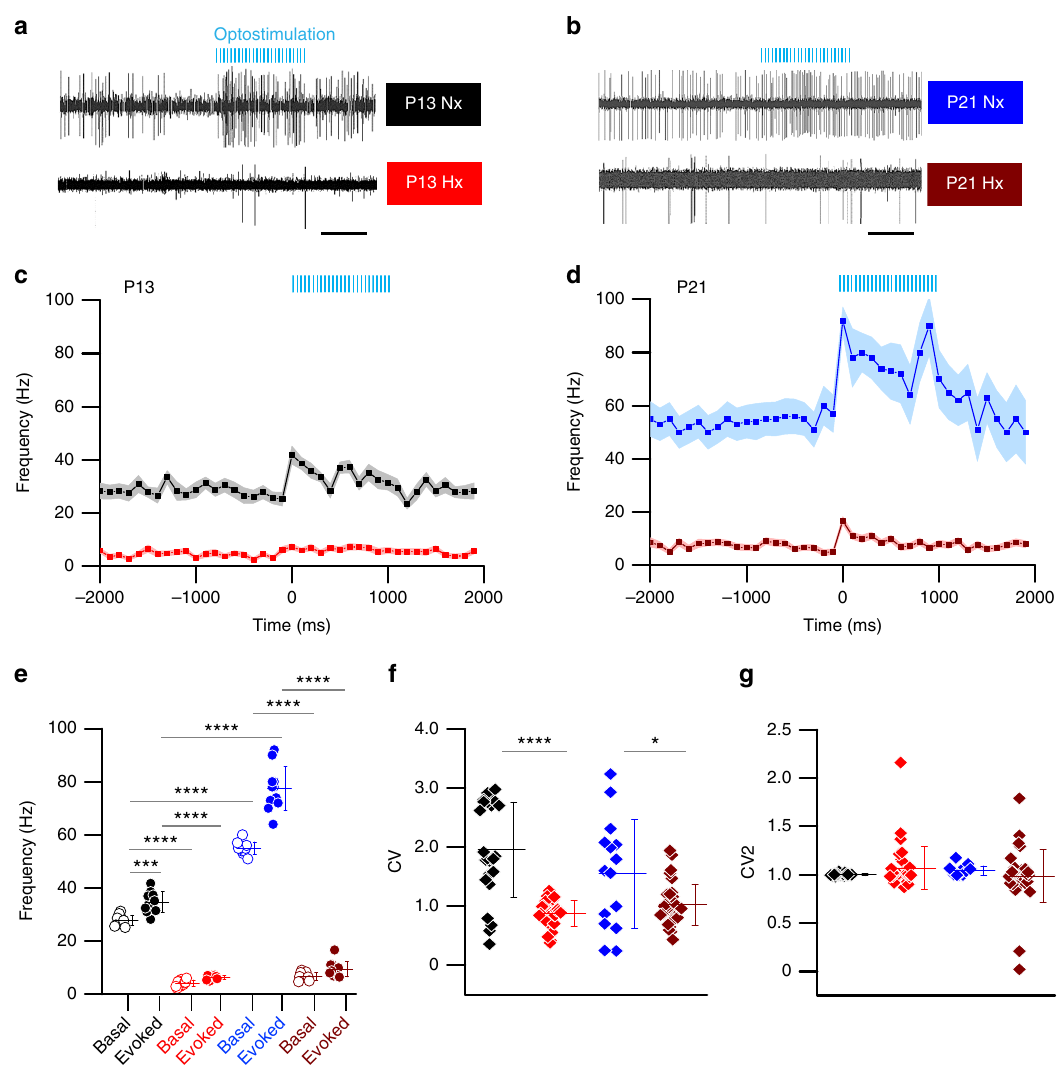
Fig. 6 Altered in vivo Purkinje cell simple spike fi ring rates in Hx and Nx Pcp2-Cre mice at P13 and P21. a Representative multielectrode array (MEA) recordings from Purkinje cells (PCs) in Nx (black) and Hx (red) animals at P13. Blue bars represent optostimulation. b Representative MEA recordings from PCs in Nx (blue) and Hx (wine) animals at P21. c Mean simple spike (SS) fi ring frequency of PCs in Nx P13 (black, n = 25 PCs), and Hx P13 animals (red, n = 37 PCs); shaded area indicates SEM for P13 Nx (light grey), and P13 Hx (light red). d Mean SS frequency of PCs in Nx P21 (blue, n = 15 PCs) and Hx P21 (wine, n = 33 PCs). SEM indicated for P21 Nx (light blue) and P21 Hx (light red). Data obtained from multiple PCs from 8 – 10 animals/group for c – d . e Scatter plot SS frequency comparison of Nx P13 basal (black, open), Nx P13 evoked (black, solid), Hx P13 basal (red, open), Hx P13 evoked (red, solid), Nx P21 basal (blue, open), Nx P21 evoked (blue, solid), Hx P21 basal (wine, open), and Hx P21 evoked (wine, closed). Each circle represents mean frequency obtained from multiple PCs/group for one sample. Ten successive timepoints were sampled pre-optostimulation and 11 successive timepoints were sampled post-optostimulation. Horizontal lines in each group represent the mean fi ring frequency across time-samples. One-way ANOVA, F (7,80) = 607.3, P < 0.0001, R 2 = 0.9815. f Scatter plot showing coef fi cient of variance of interspike interval (CV) for basal PC fi ring in Nx and Hx animals. Each diamond represents individual CV values from the same set of PCs for which frequency plots are analyzed in c – e . One-way ANOVA, F (3,106) = 22.24, P < 0.0001, R 2 = 0.3863 . g Scatter plot showing CV2 values of basal PC fi ring in Nx and Hx animals from the same data set as c – f . One-way ANOVA, F 0.3349, R 2 = 0.03079). Scale in a and b represent 500 ms. Error bars in e – g denote SEM. Asterisks represent results of Tukey ’ s multiple comparison test following one-way ANOVA * P < 0.05, *** P < 0.001, **** P <